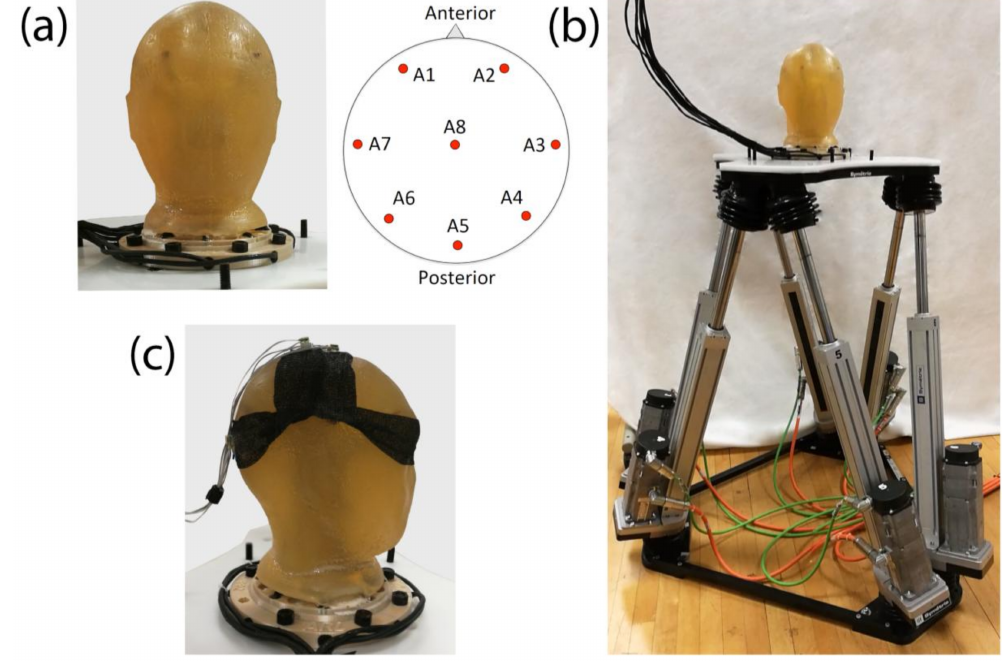
Figure 1. The Setup: ( a ) ballistics gel phantom head and antenna locations; ( b ) the motion hexapod platform with the head attached to it; ( c ) electrode placement on the ballistics gel phantom. Electrodes were placed on the top of the head (perpendicular to the motion) and on the back of the head (parallel to the motion). The CMS/DRL electrodes were also placed on the top of the head behind the recording